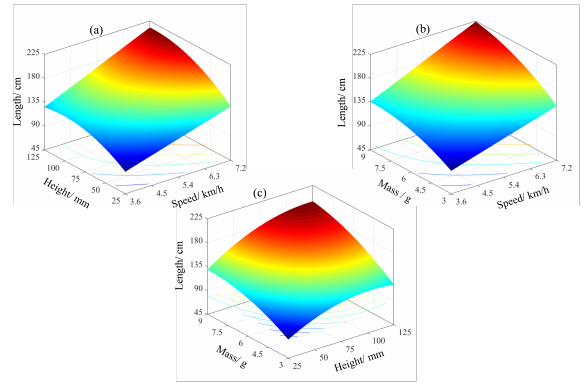
Fig. 8. Interactions among the various factors with the fertilizer distribution